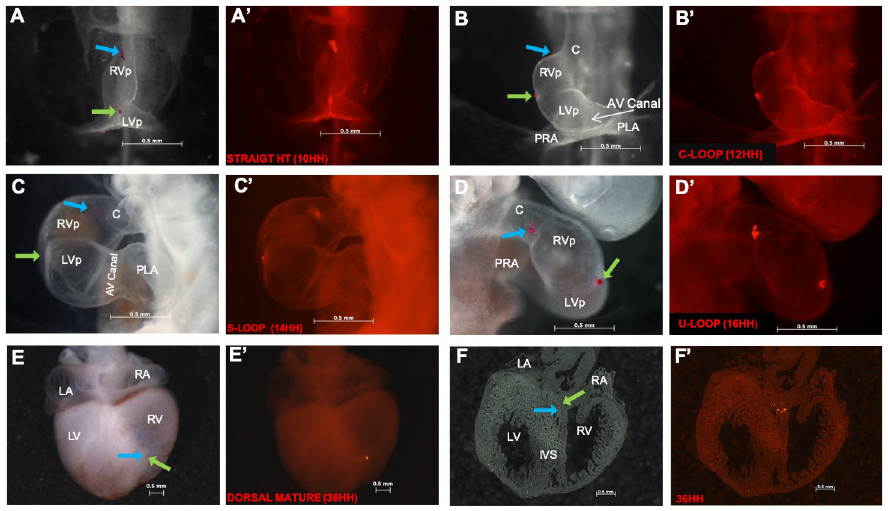
Fig 1. Anterior segment of the straight heart tube is involved in the development of the apical and medial thirds of the interventricular septum. (A, A’) Bright field and fluorescent microscopy images of the straight heart tube with the anterior segment delimited by the cephalic (blue arrow) and caudal (green arrow) labels. (B, B’–D, D’) C-, S-, and U-looped hearts. Note the anterior segment of the straight heart tube displaced to the supposed right ventricular primordium. The cephalic label (blue arrow) is located in the distal region of the ascending branch of the loop near the limit between the conus and the right ventricle primordium. The caudal label (green arrow) is located at the midpoint of the great curvature, at the level of the supposed interventricular septum precursor. (E, E’) Dorsal view of a tetracavitary heart (HH34) revealing the labels at both limits of the straight heart tube converging at the right ventricular apex. (F, F’) Histological sections of a tetracavitary heart showing the caudal label (green arrow) immersed in the myocardium at the middle third of IVS. Abbreviations: AV, atrioventricular; C, conus; LA, left atrium; LV, left ventricle; LVp, left ventricle primordium; PRA, primitive right atrium; PLA, primitive left atrium; RA, right atrium; RV, right ventricle.